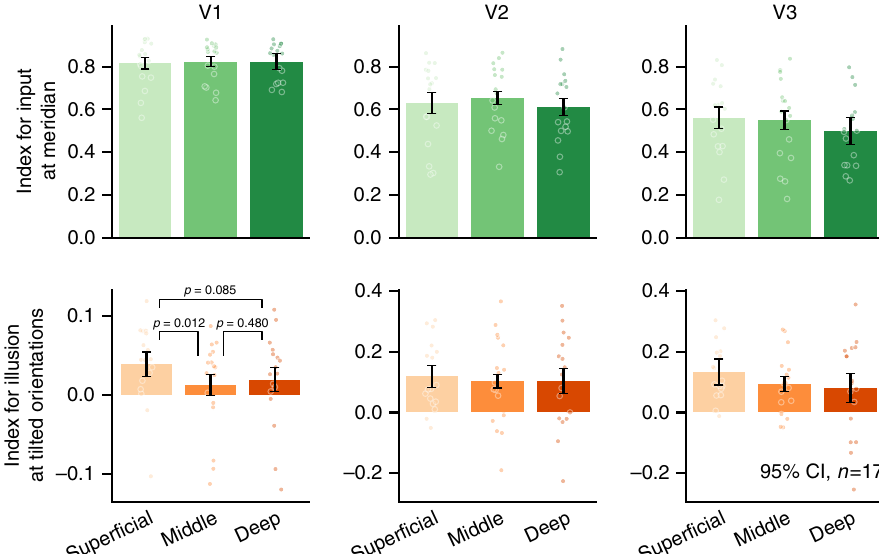
Fig. 3 Representations corresponding to retinal input and illusory percepts across different layers of early visual cortices. fMRI response to the clockwise and counter-clockwise tilted illusions were calculated as a function of bar angle coordinates across the fi eld of bar rotation. The computed response index for input representation at the horizontal meridian was based on the mean BOLD responses between − 4° to 4° polar angles, while the illusory index was based on the mean BOLD response differences between two experimental conditions (clockwise vs. counter-clockwise) at both − 14° to − 6° and 6° to 14° polar angles. The representation index for the “ illusory orientation ” was signi fi cantly stronger in V2 and V3 than in V1 (two-way repeated measure ANOVA, F (2, 32) = 9.72, p < 0.001; Post hoc Holm corrected, V1 vs. V2: t (16) = − 3.23, p = 0.010, d = − 0.783, V1 vs. V3: t (16) = − 4.14, p